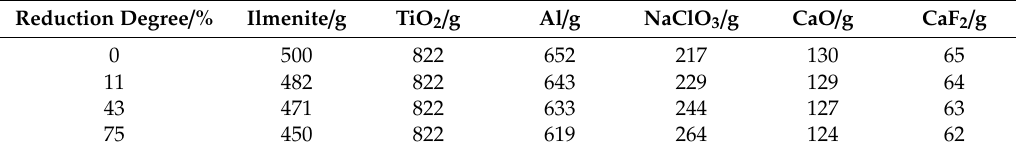
Table 1. Materials ratios in the experiment.